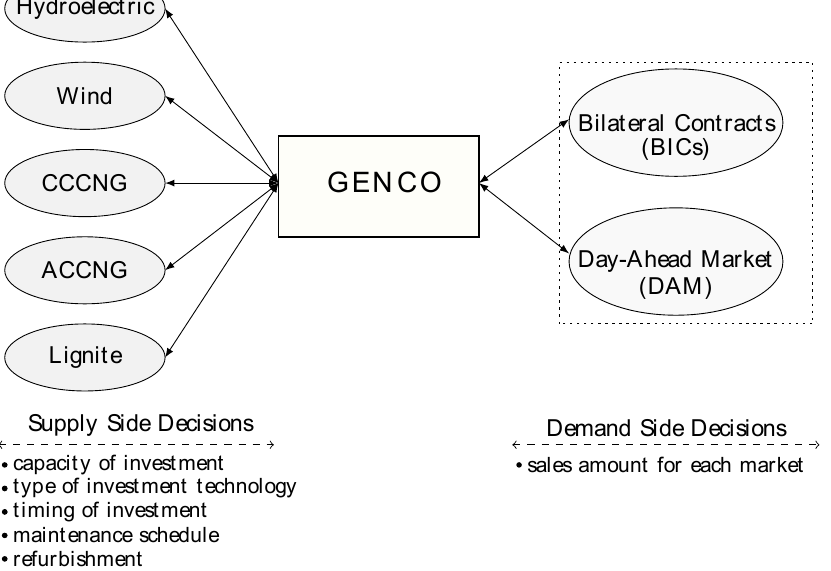
Figure 1. Electricity market environment for a GenCo.